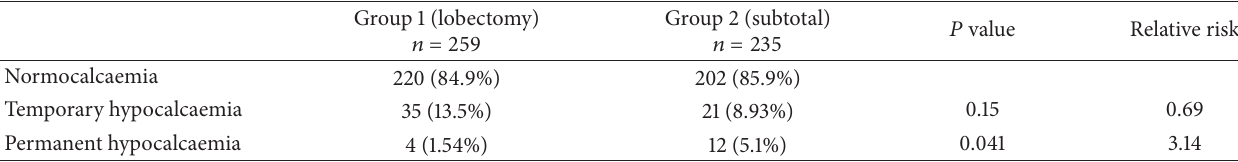
Table 3: Incidence of hypocalcaemia following reoperative